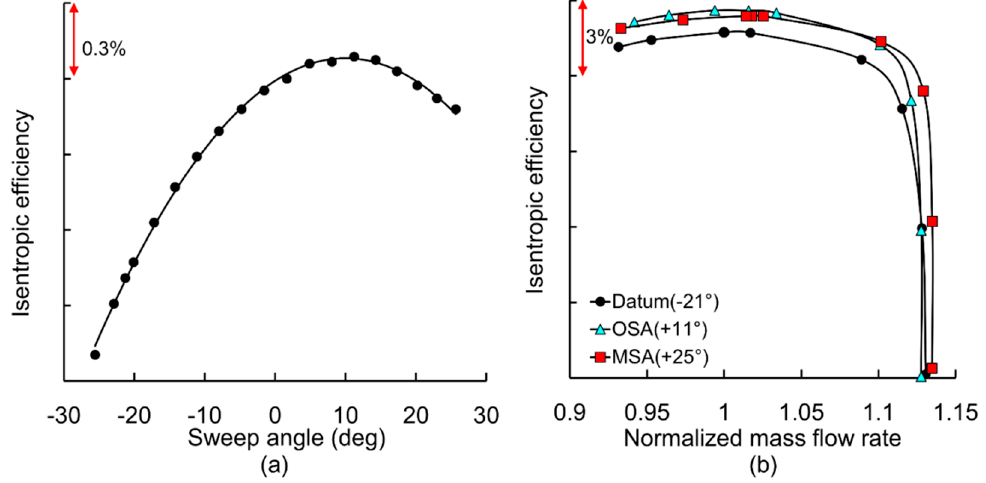
Figure 10. Efficiency: ( a ) trend with sweep angle and ( b ) design speed performance comparison. OSA: optimal sweep angle; MSA: maximum sweep angle.